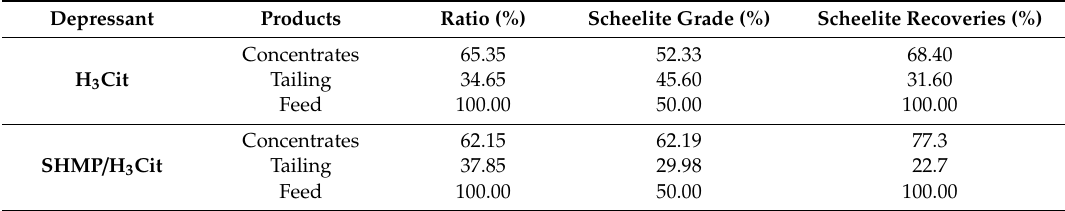
Table 1. Flotation results of artificial mixed